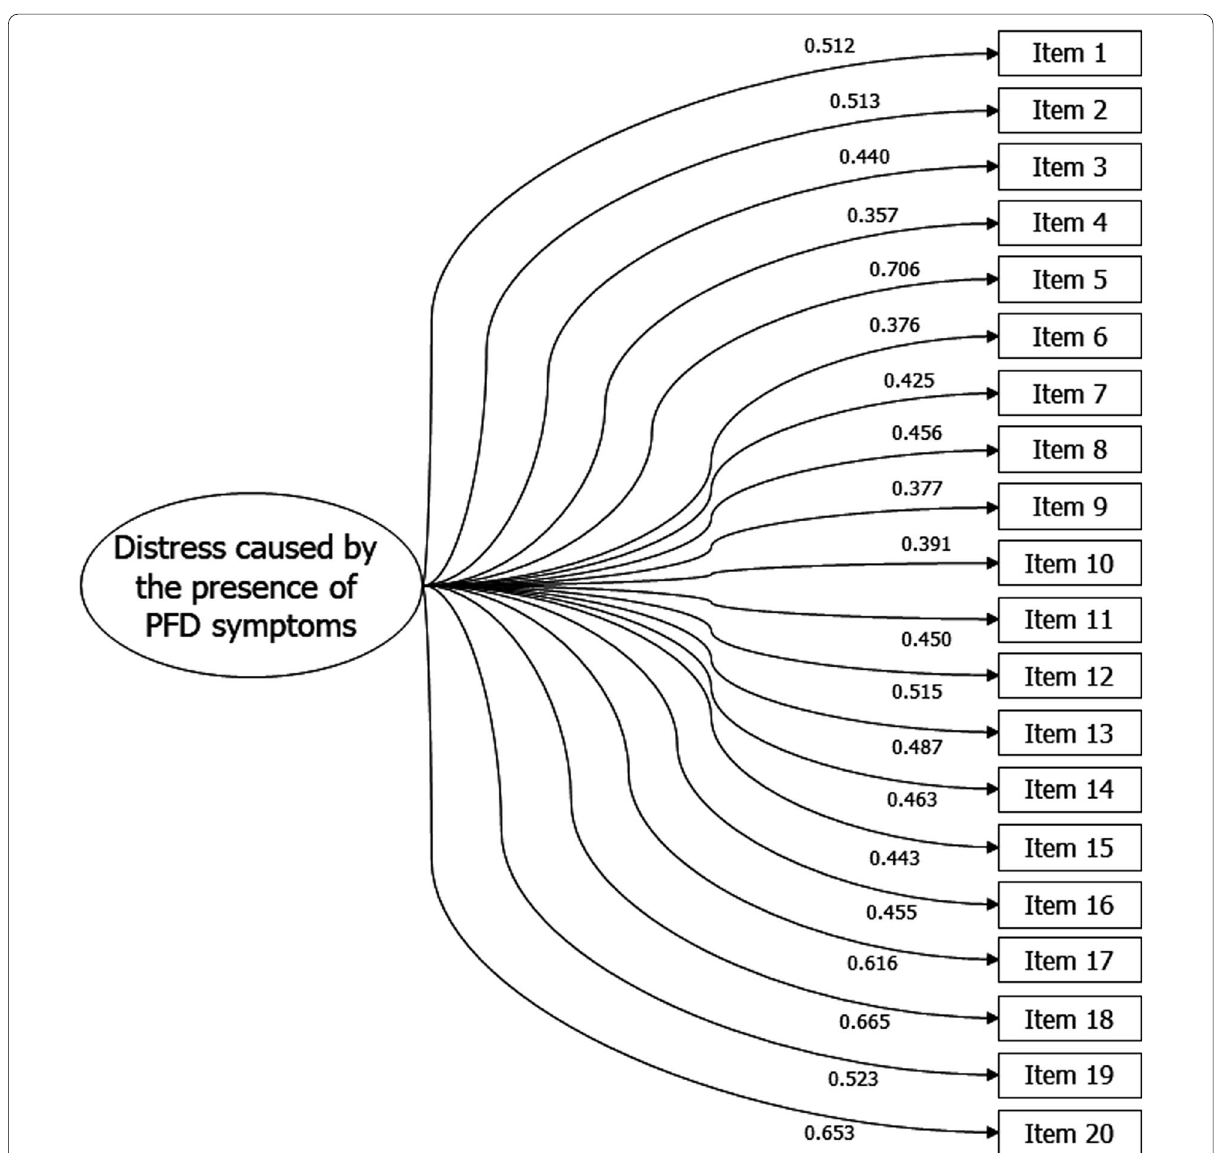
Fig. 1 Path diagram of the one-dimensional model for PFDI-20. Pelvic Floor Dysfunction, PFD